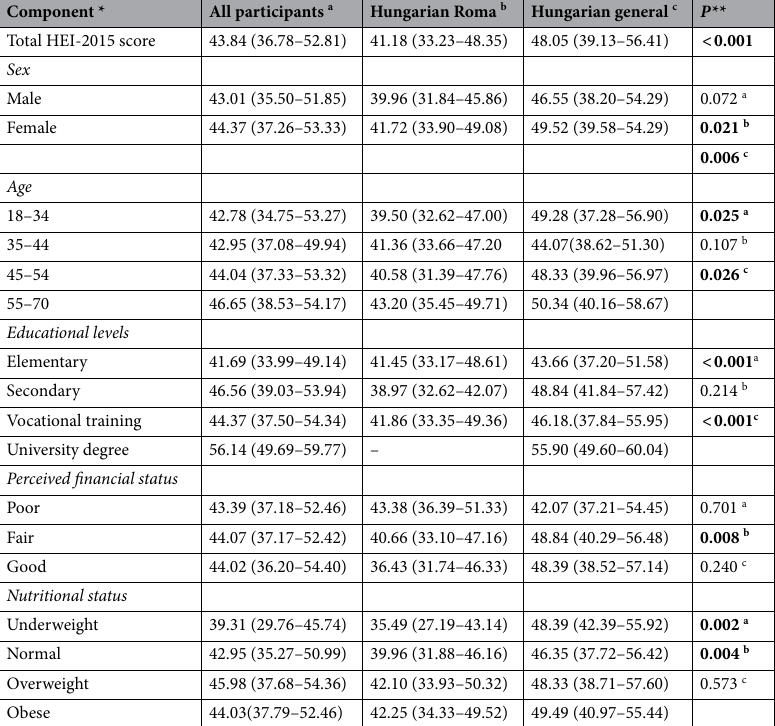
Table 4. Average Total Healthy Eating Index 2015 scores by sex, age, educational status, perceived financial situation, and BMI categories. *Values are medians (25–75th percentiles). **Differences in distribution of scores were evaluated by Mann–Whitney or Kruskal–Wallis test. Bold values represent significant differences between socioeconomic variables within groups of all participants a , Hungarian Roma b , and Hungarian General c